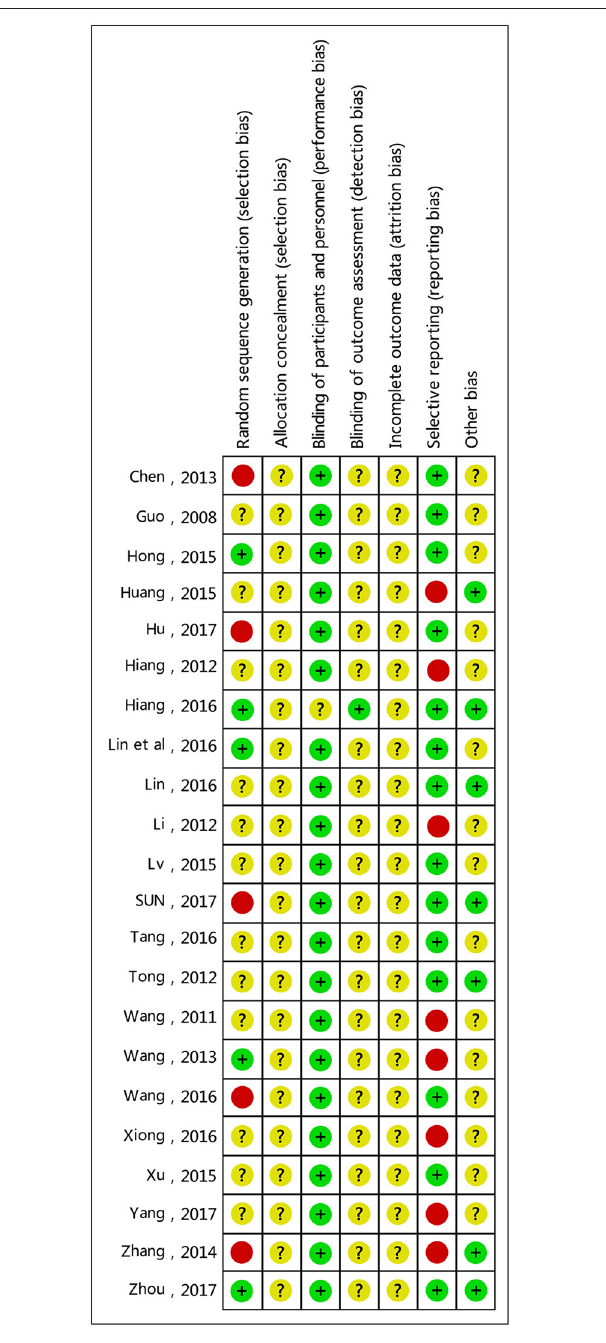
FIGURE 3 | Summary of bias risks: the reviewers’ judgment of risk for each bias item in each included study.